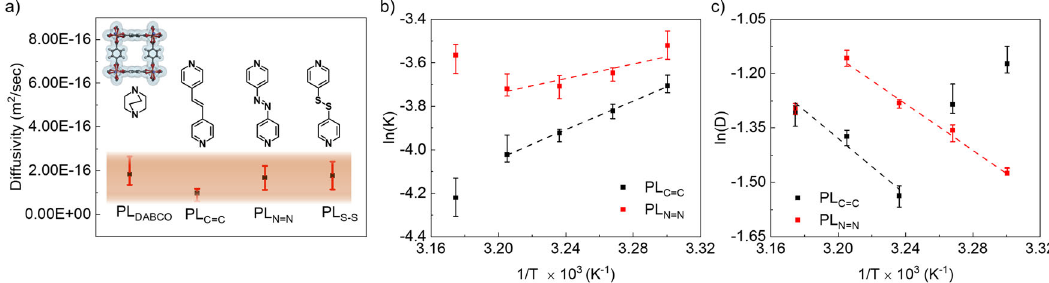
Fig.4|Methanoldiffusivity.a Comparisonofthediffusivitiesat298KforPLMOFs with oriented pores; the speci fi c van der waals surface added pore is shown in the inset; for all the PLs with different pillars the accessible pores at the surface are